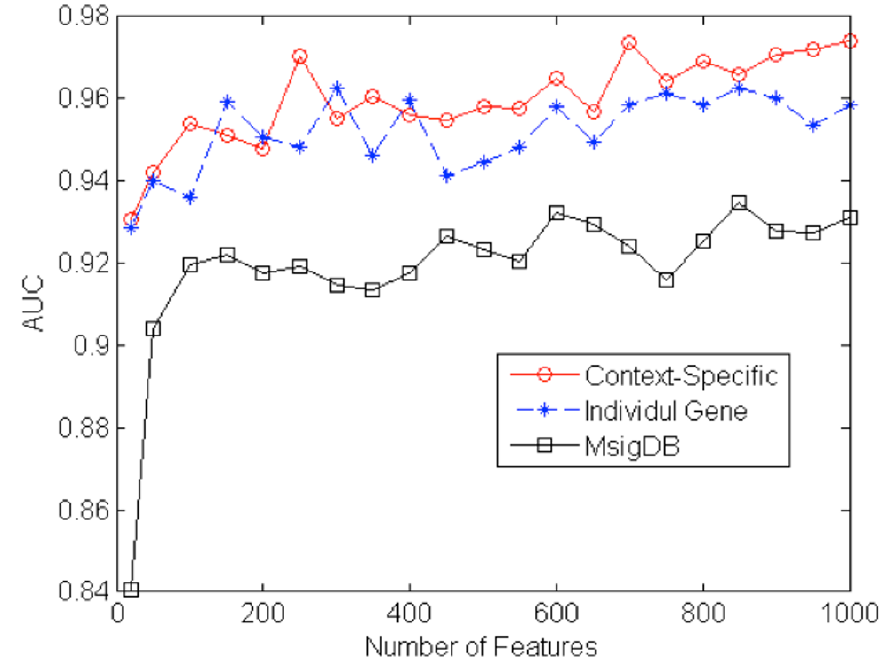
Figure 6: Comparison of the classification performance using (a) individual gene expression profile, (b) CSGS expression, and (c) MSigDB gene sets